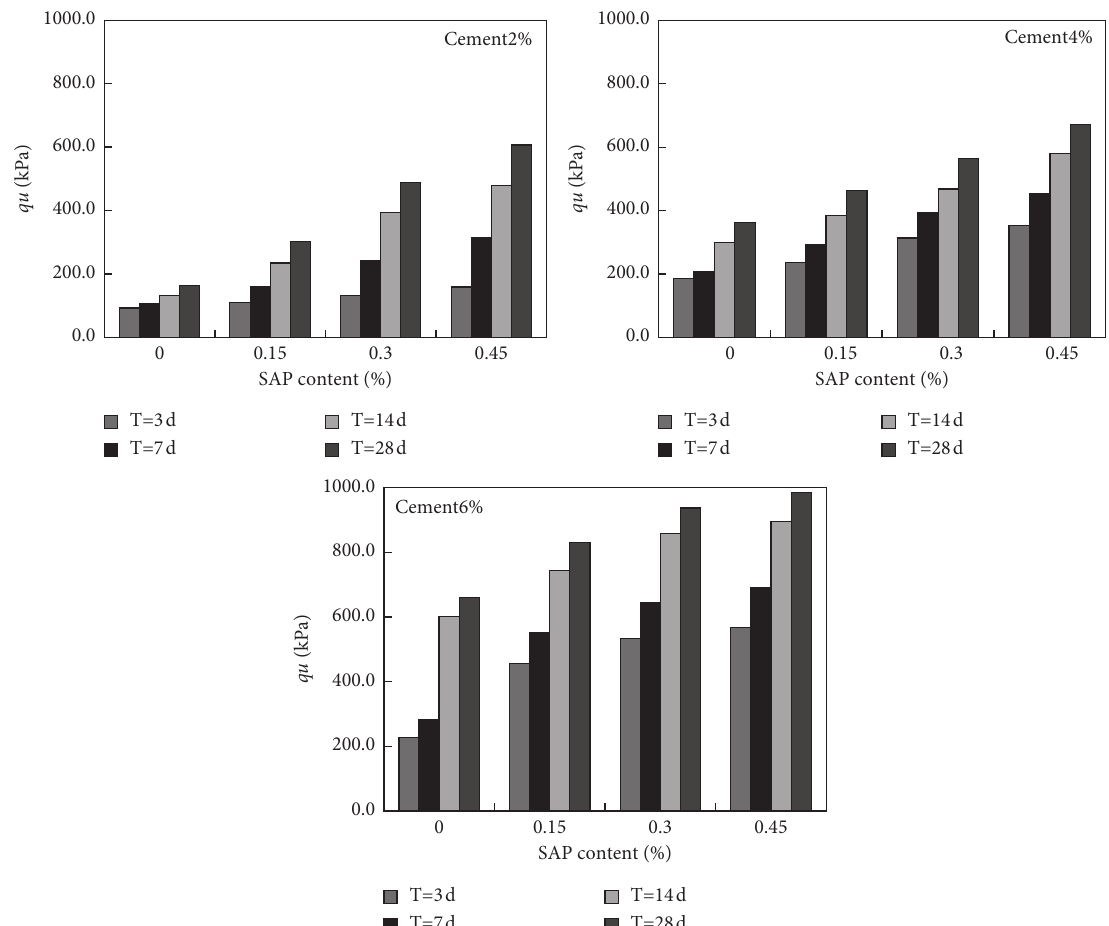
Figure 2: Effect of SAP content on q